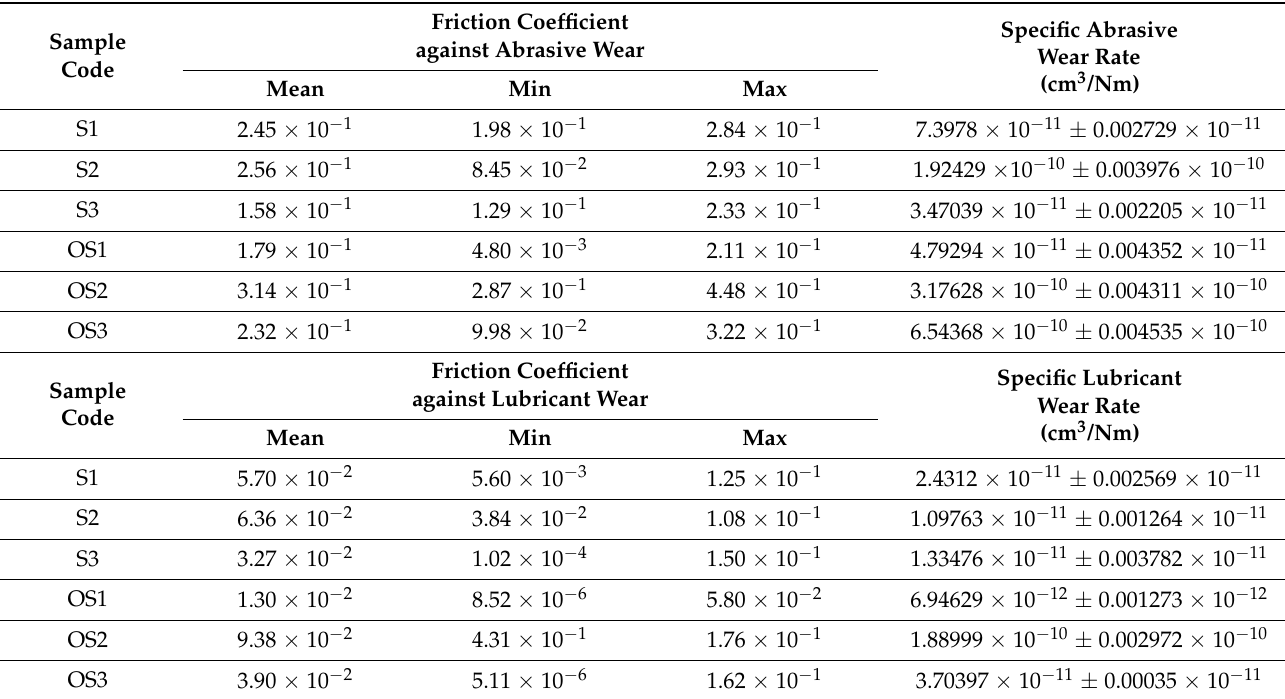
Table 4. The tribological results against abrasive and lubricant wear conditions for the stainless steel grades, before and after heat-treatment